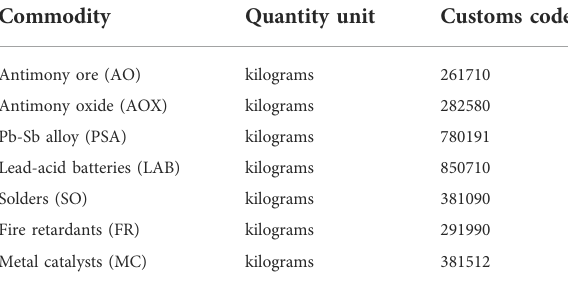
TABLE 1 International trade of commodities in the antimony industry chain. Commodity Quantity unit Customs